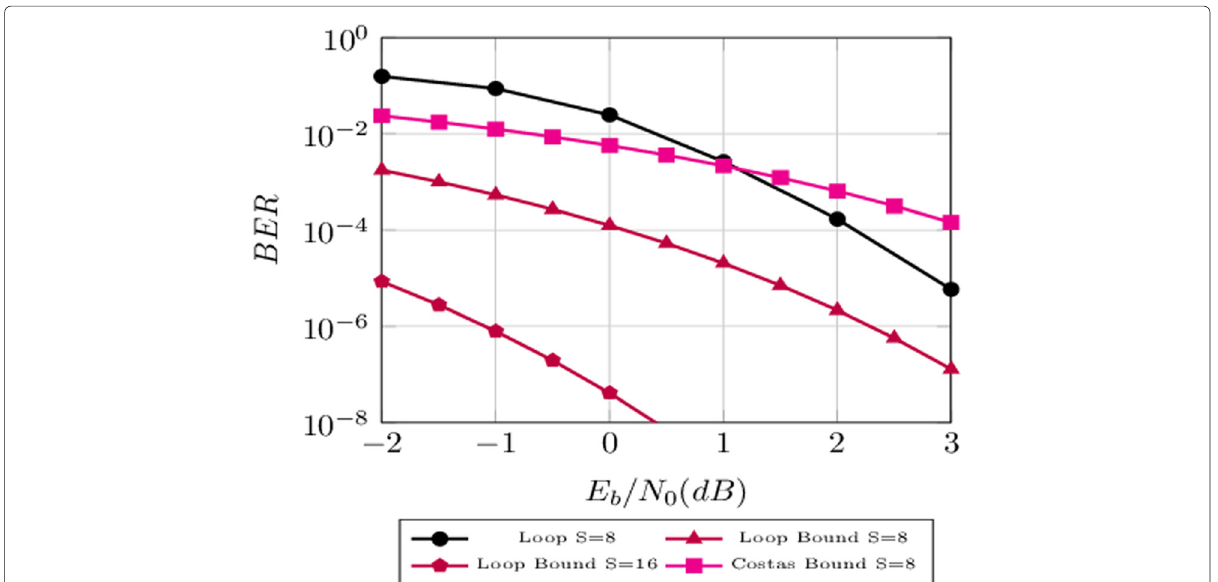
Fig. 9 Simulated error rate of recovery loop ( S = 8) theoretical lower bound BER when S = 8,16 and finally Costas’ loop bound BER ( S = 8). High oversampling rate ideally improves the error rate, but the hardware implementation could be difficult to